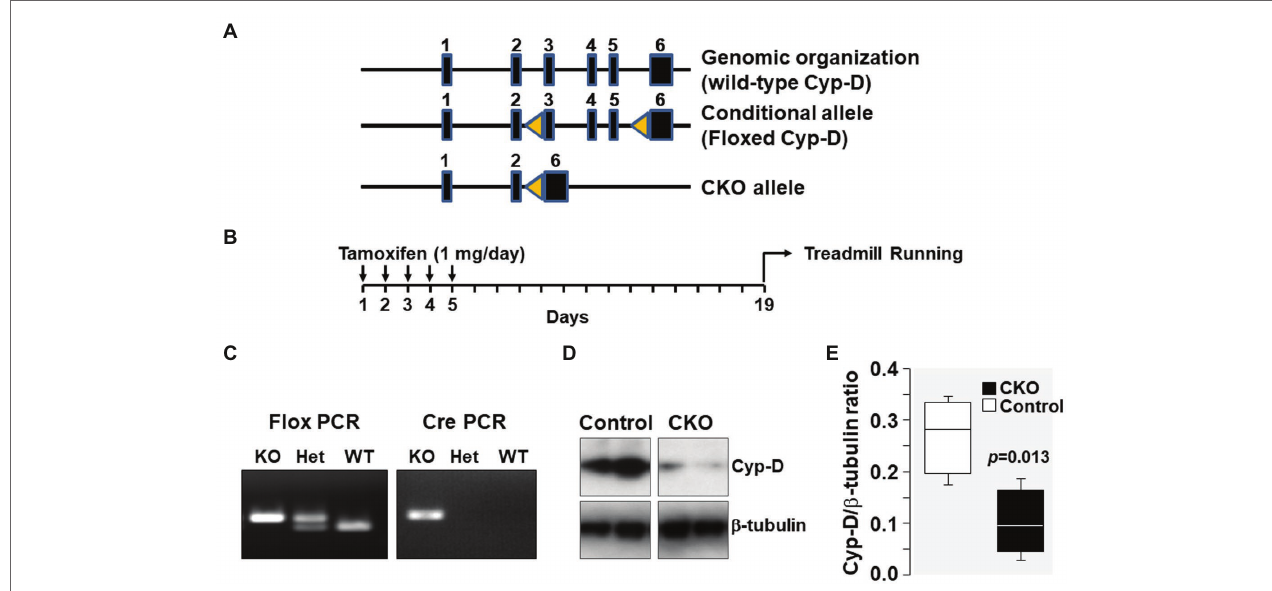
FIGURE 1 | (A) Genomic organization of Cyp-D encoding ppif gene in mouse chromosome 14 is shown. The ppif gene has six exons which are represented by closed boxes. Genomic organization of floxed Cyp-D in which exons 3–5 has flanking lox-P sites (yellow triangles) is shown as conditional allele. The floxed Cyp-D mouse was generated by Stanley J. Korsmeyer’s lab. Genomic organization of conditional knockout (CKO) allele showing deletion of exons 3–5. (B) Schematic demonstrating time of tamoxifen treatment. (C) Ppif Fl/+ -Cre /+ mice pups were genotyped to confirm the presence of Ppif Fl/+ and Cre genes. (D) Western blot showing Cyp-D protein in skeletal muscle tissue homogenates of control and cyclophilin-D conditional knockout (CKO) mice. (E) Box plots denote densitometry of Cyp-D normalized to β